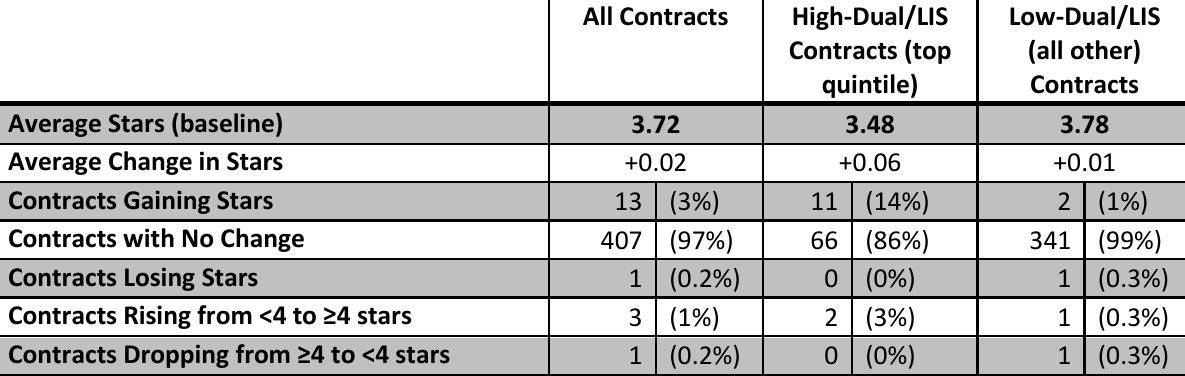
Table 8.10: Adjusting Quality Star Ratings using a Categorical Adjustment Index (Appendix Table